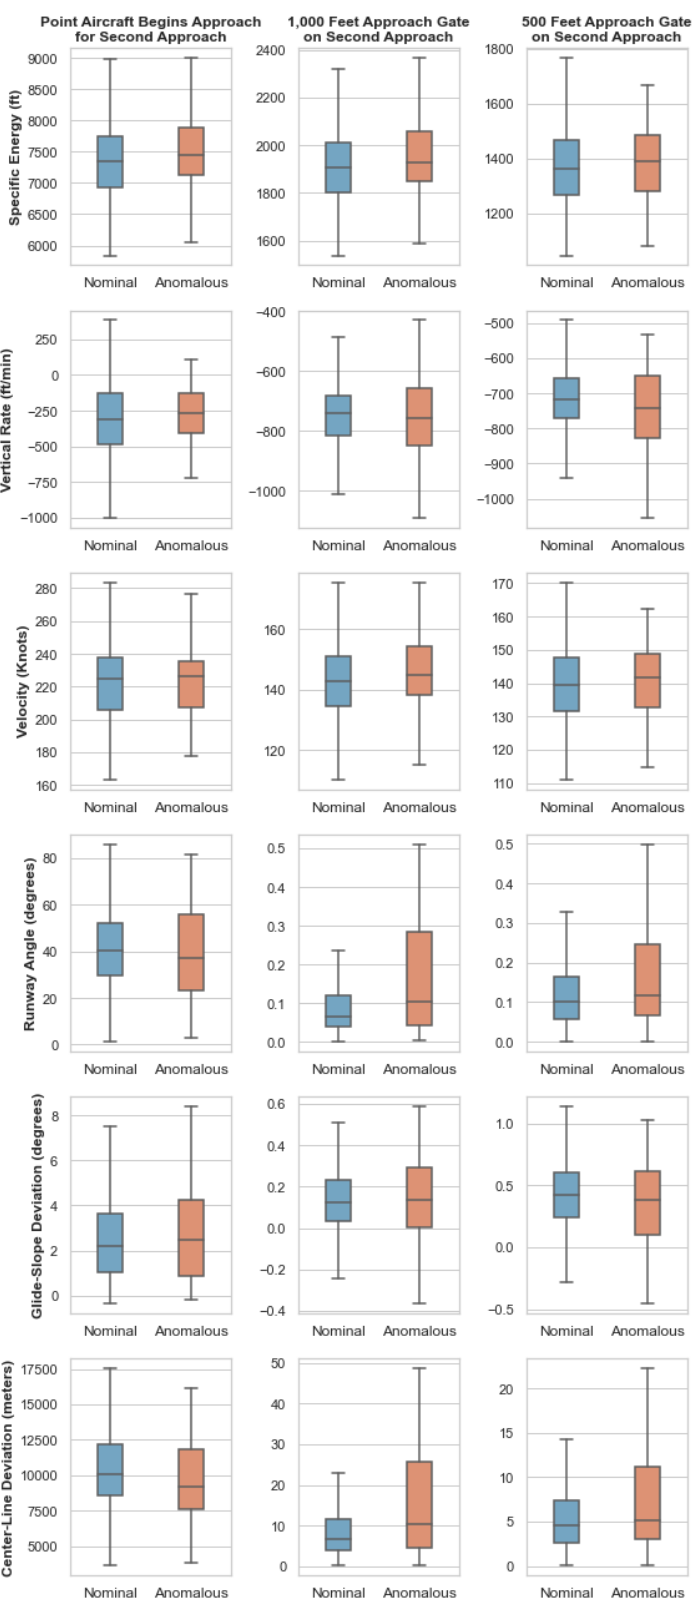
Figure 8. Box-plots of different features at points on landing after go-around. Glide-slope deviation and centerline deviation at the point at which the aircraft began its second approach were not included in the feature vector for clustering but the plots are